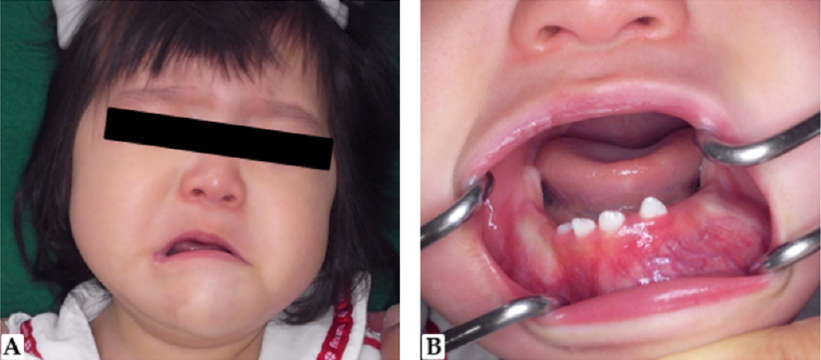
Figure 7. Pictures of the patient at the age of 8 months. ( A ) Facial frontal view; ( B ) intraoral view showing swelling in the left mandibular region.